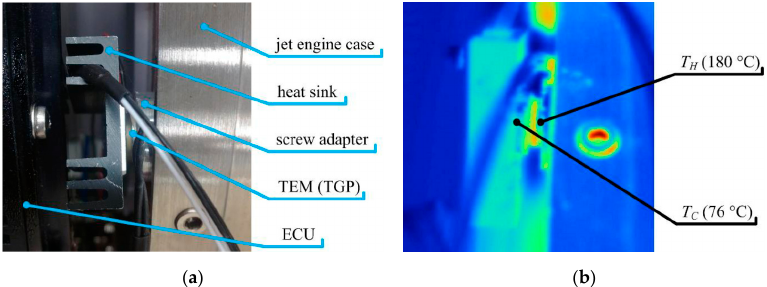
Figure 23. TEG demonstrator ( a ) and thermographic image of its location ( b ) [157]–reprinted by permission from Elsevier.